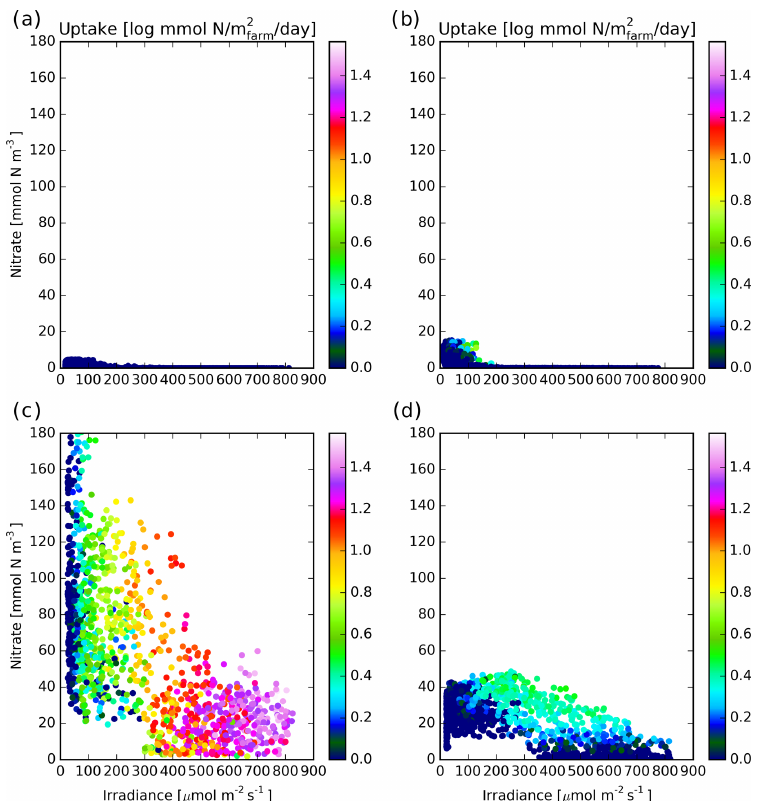
Figure 14. Logarithm of nitrogen uptake as a function of irradiance and nitrate concentrations in the model: (a) Strangford Lough farm, (b) Sound of Kerrera farm, (c) Rhine plume farm and (d) Norfolk